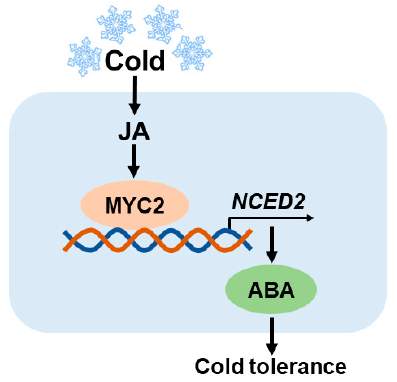
Figure 6. Simplified model that depicts how jasmonate regulates ABA biosynthesis in response to cold stress. Upon cold stress, JA accumulation is increased in tomato, initiating JA signaling and activating MYC2 . MYC2 acts on the promoter of ABA biosynthesis gene NCED2 and promotes its transcription, leading to increased accumulation of ABA. Thus, JA-mediated cold tolerance is partially dependent on JA-induced ABA biosynthesis in tomato.